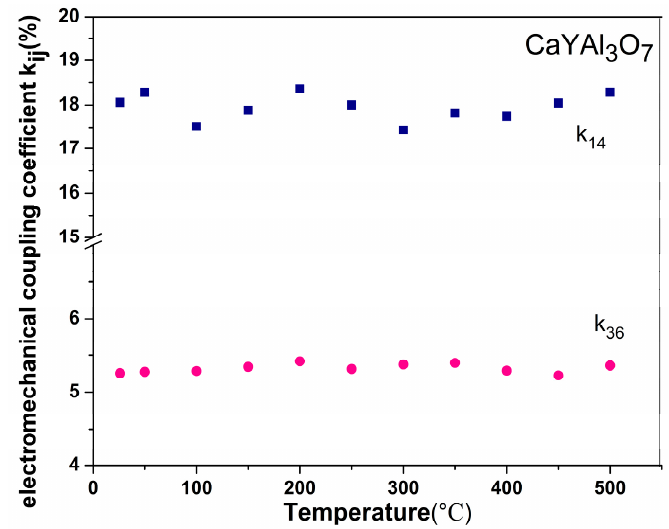
Figure 8. Electromechanical coupling factor of CYAM crystal as a function of temperature. Table 3 First-, Second-, and Third-Order Temperature Coefficients of the Elastic Constants.